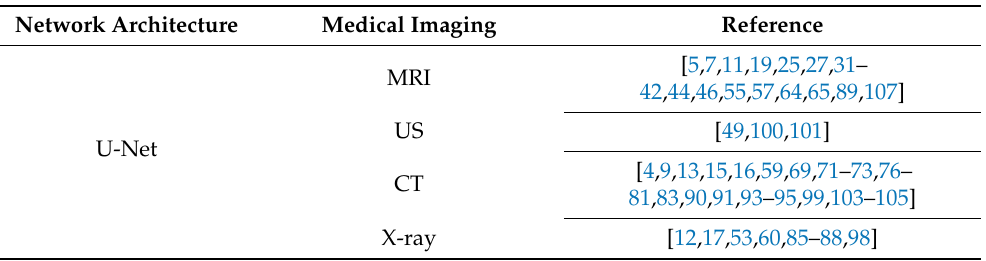
Table 4. The most common deep learning network architecture applied to musculoskeletal structures, matched with bioimaging